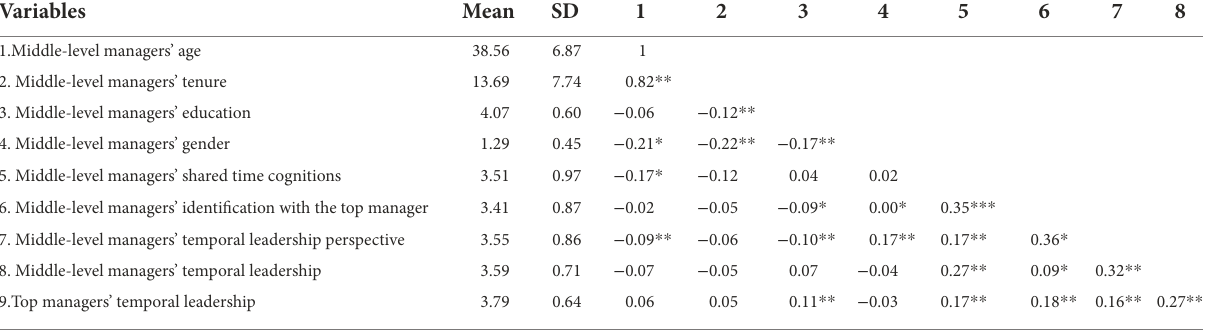
TABLE 1 Means, standard deviations, and correlations.